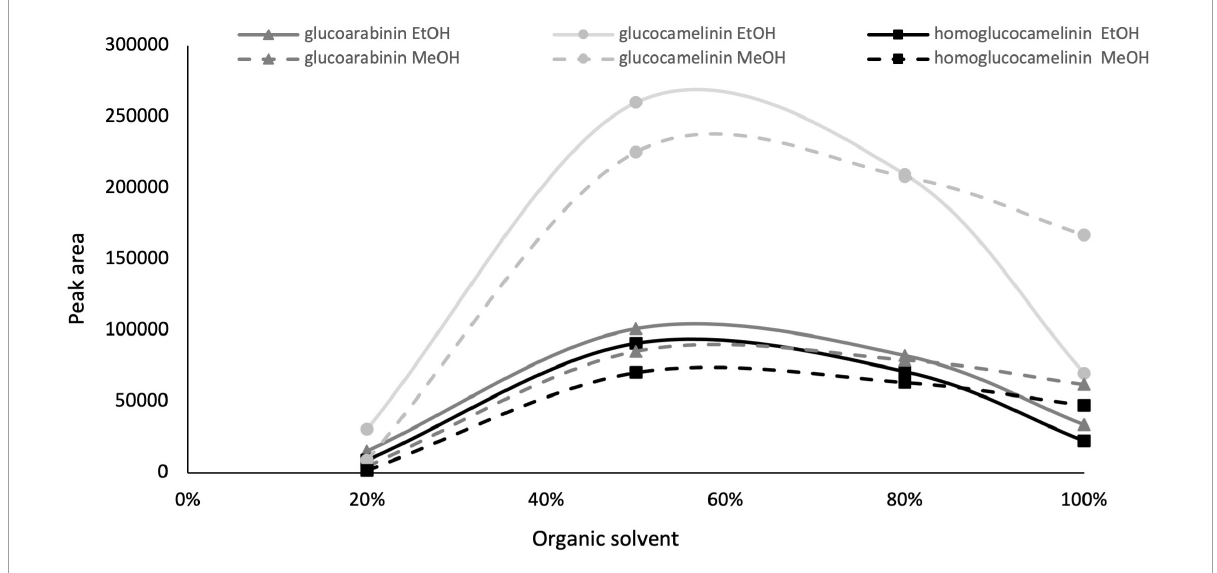
FIGURE1 Glucosinolate peak area vs. organic solvent percentage, ethanol (solid line) and methanol (dashed line).